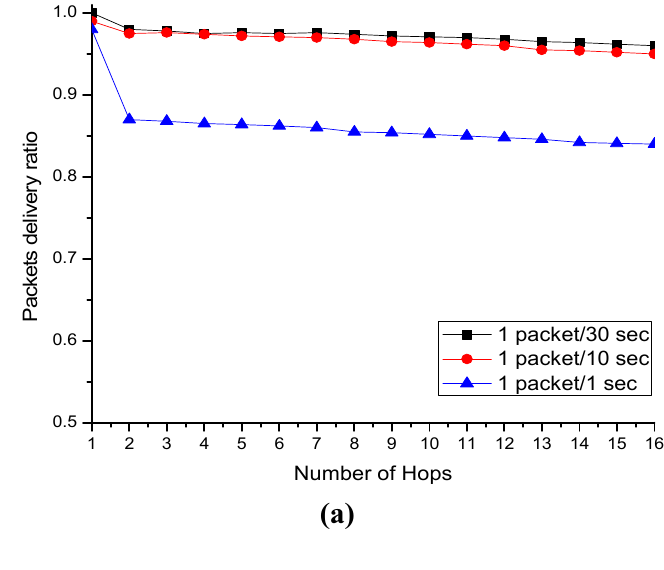
Figure 21. Delivery ratio vs. number of hops. ( a ) Multiple nodes to SMAG delivery; ( b ) End-to-end